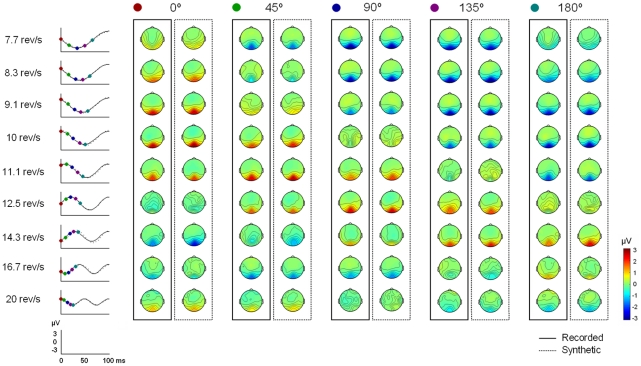
Voltage topography for both recorded and synthetic data (Experiment 2).Scalp voltage topographies for the dominant frequency of each condition (rows) and phase angle (columns) from 0° to 180°. Recorded topographies are presented in the solid boxes; synthetic topographies, in the dashed boxes. The time points corresponding to each phase angle are indicated by its corresponding colour in the time courses of the frequency amplitude at Oz shown on the left side. Phase angles are referred to stimulus onset (i.e. 0° phase angle corresponds to 0 ms).